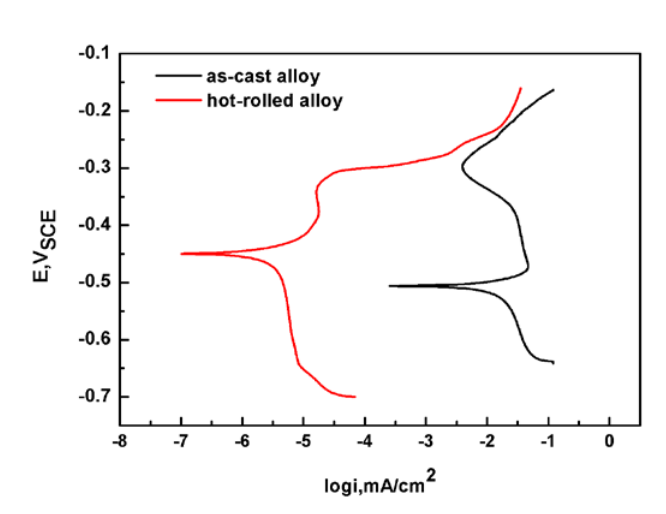
Figure 7. Polarization curves of the two states of Fe 85 Ga 15 alloys in the 3.5 wt % NaCl solution.